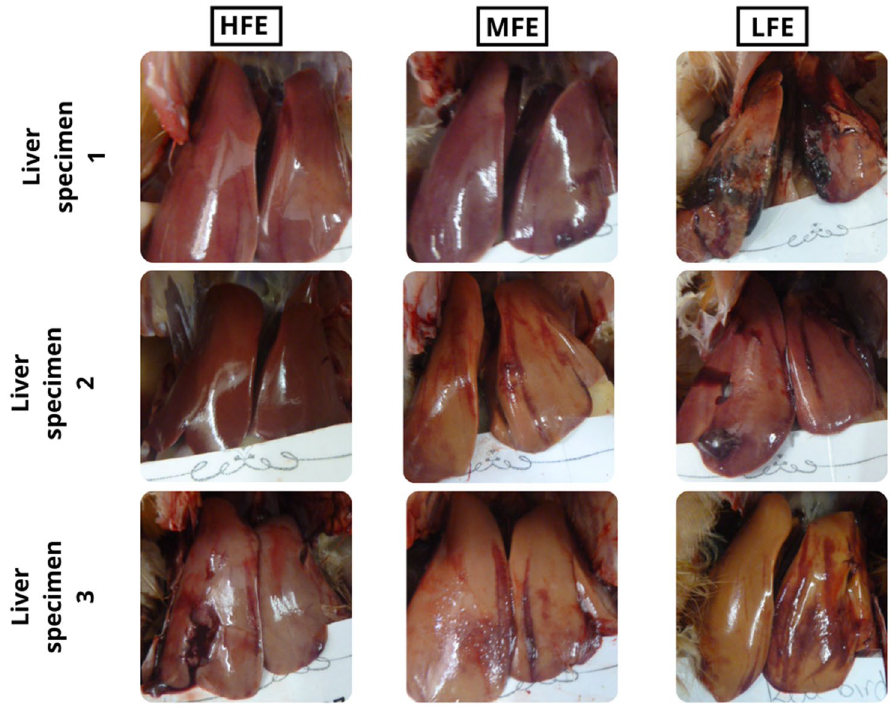
Figure 5. Examples of the physical gross appearance of livers of individually housed ISA Brown hens aged 45 weeks old ranked on the basis of feed efficiency. HFE, high feed efficiency; MFE, medium feed efficiency; LFE, low feed efficiency.